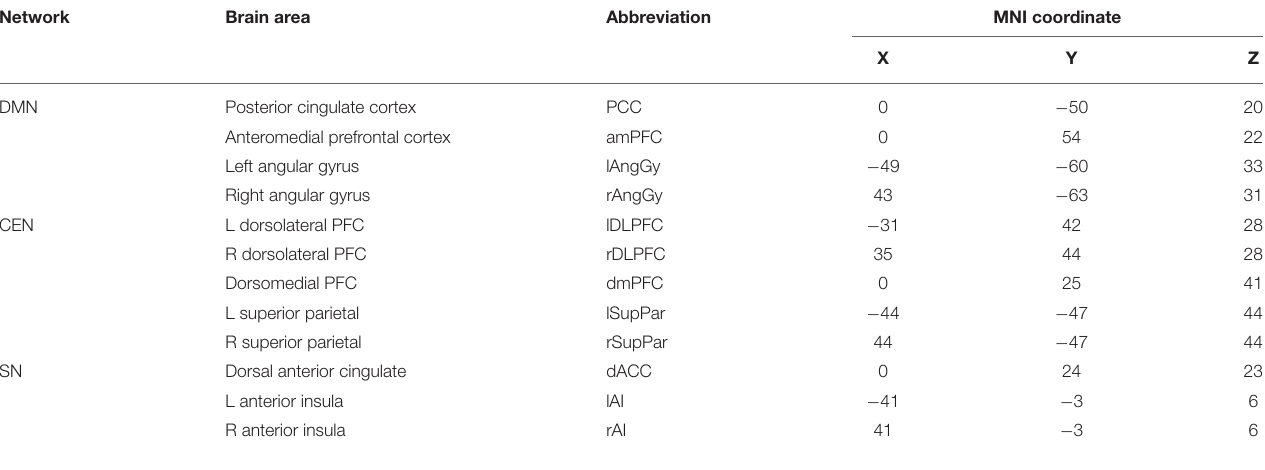
TABLE 1 | Network of interest and MNI